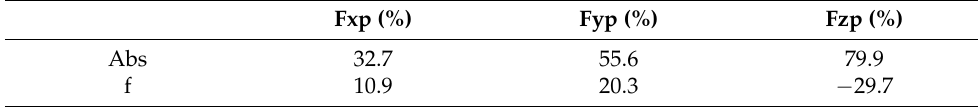
Table 8. Results for ap = 0.6 (mm) and vc = 160 (m/min).